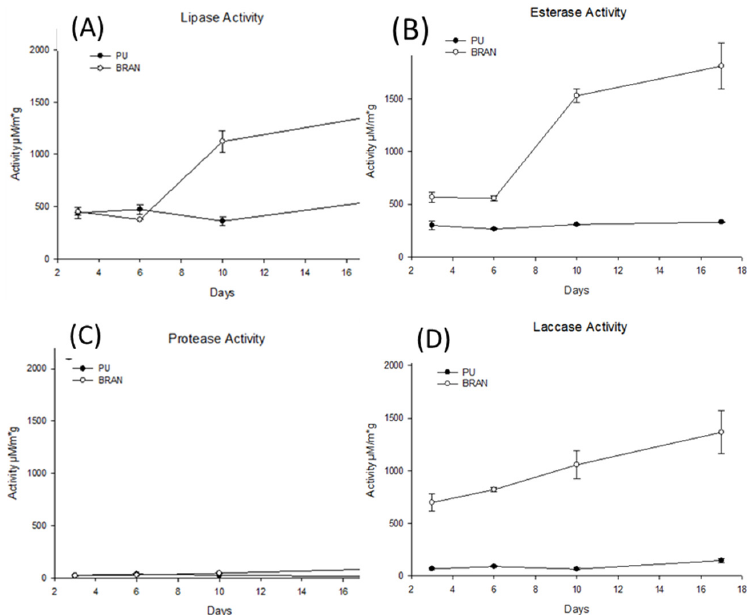
Figure 4. Polyurethane activity throughout the experiment for both PU and bran diets ( A ) lipase activity; ( B ) esterase activity; ( C ) protease activity; ( D ) laccase activity. For all the enzyme activity, a Two-Way ANOVA (Pdiet < 0.001); (Ptime < 0.001) was performed.